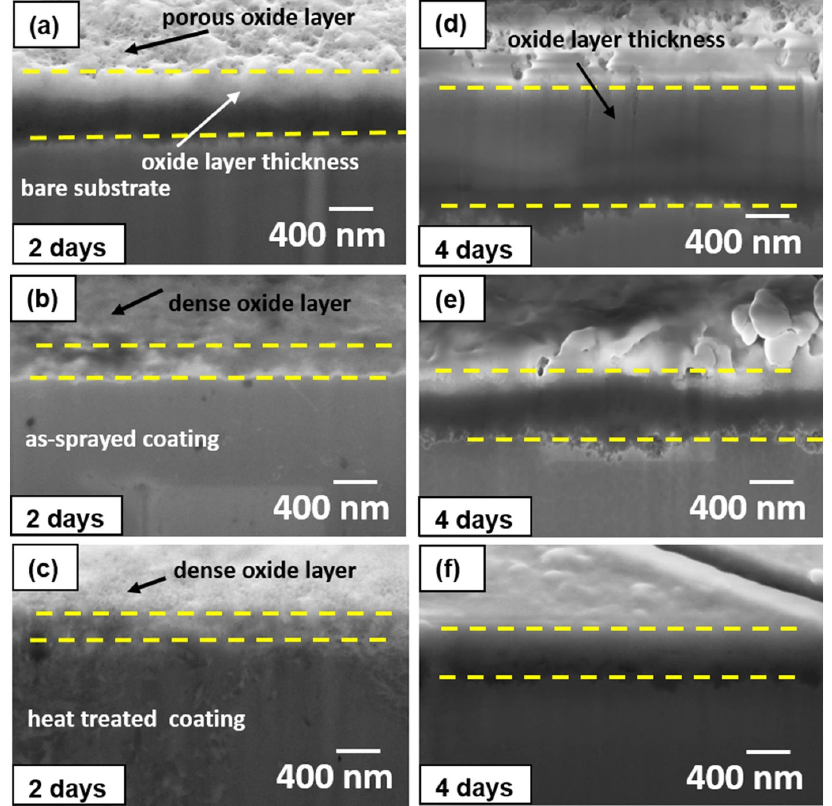
Figure 6. SEM images of milled regions showing the reactive layers after 2 days and 4 days of expo-